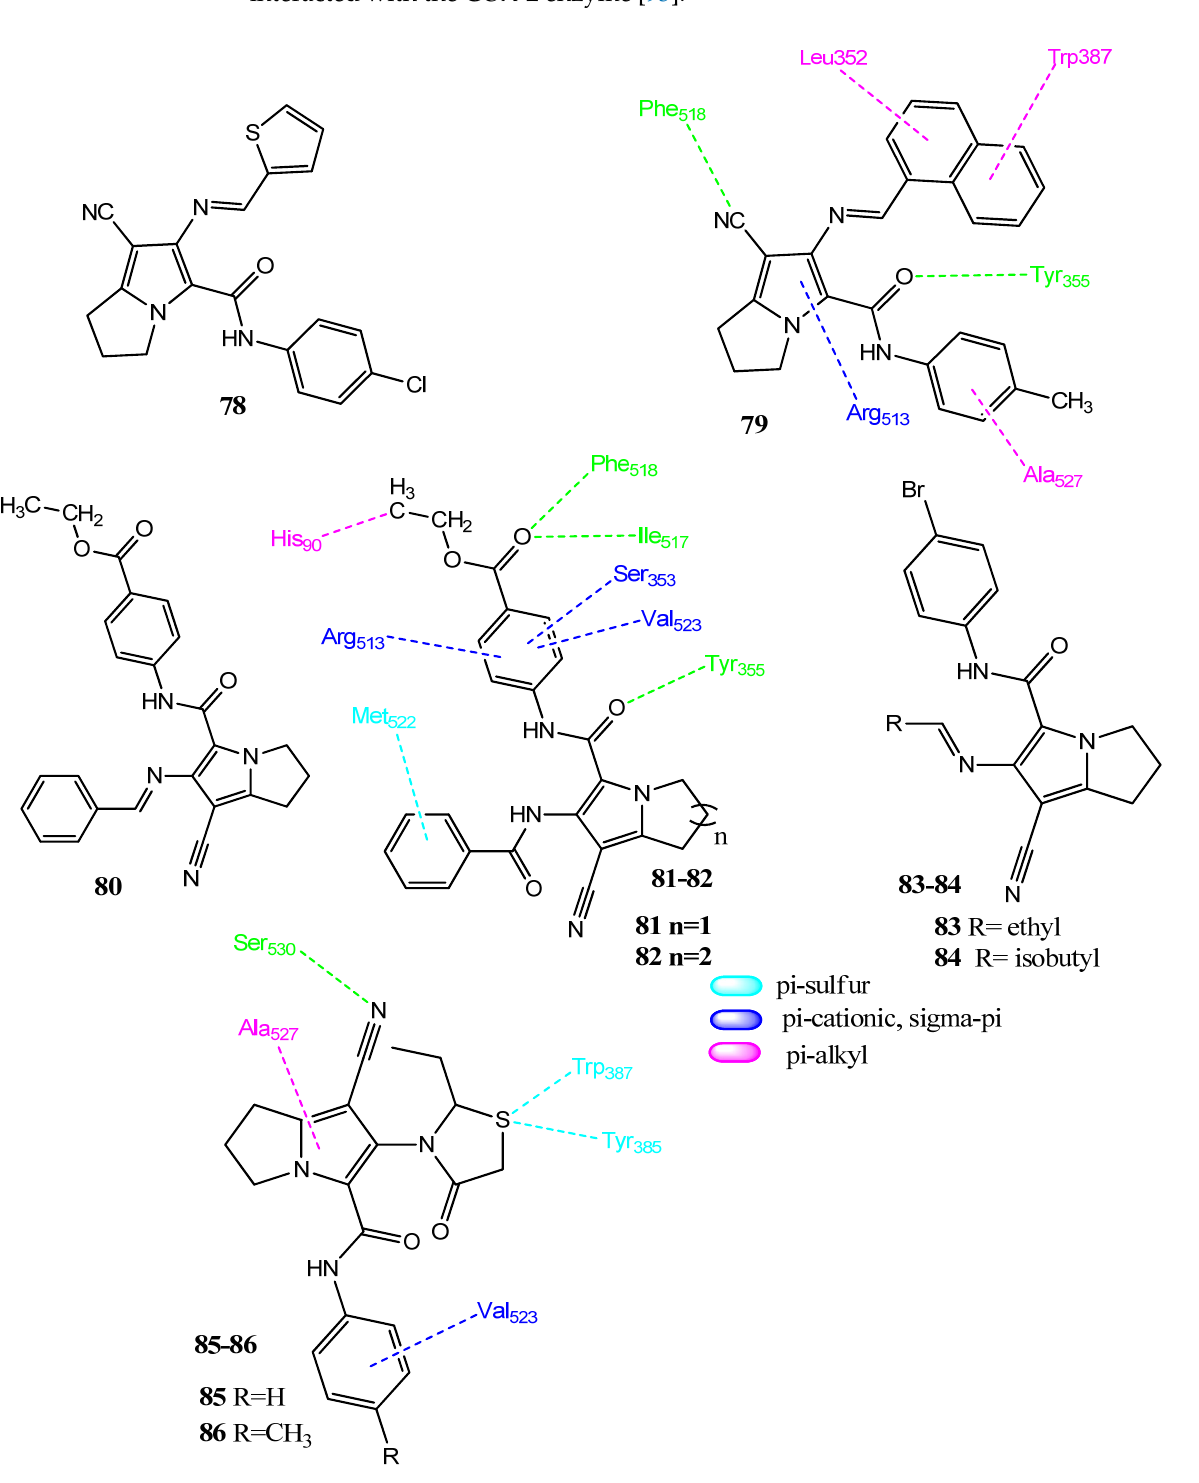
Miladiyah et al. synthesized new xanthone derivatives to which hydroxyl and halogen substituents were attached. Derivative 87 (Figure 18) was the most potent (IC 50 = 37.79 µM; SI = 66.40) against the colorectal cancer (WiDR) cell line, compared to doxorubicin (IC 50 = 3.04 µM; SI = 49.38). The molecular docking investigation of compound 87 showed that it is involved in interactions with telomerase, COX-2, and cyclin- dependent kinase (CDK). This compound was found to be non-toxic for the normal VERO